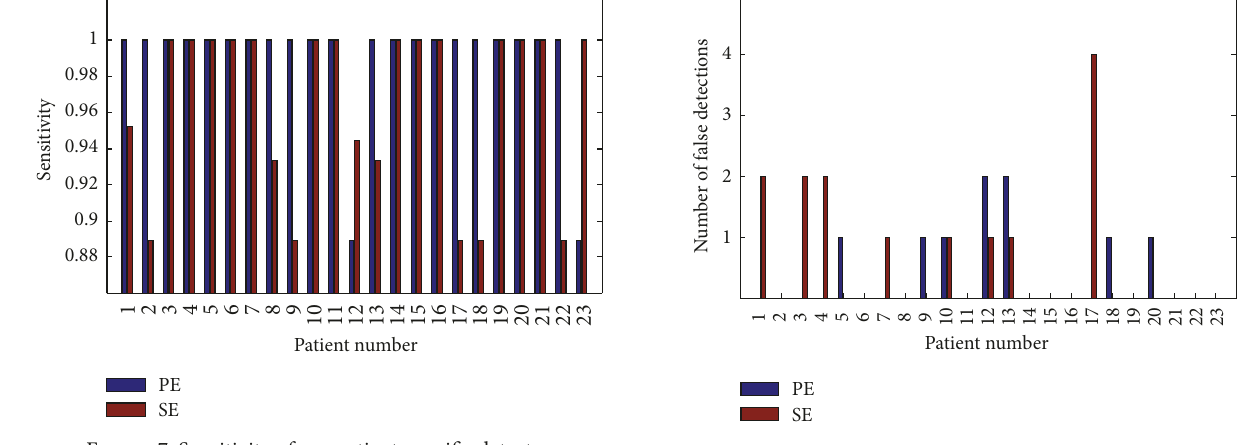
Figure 7: Sensitivity of our patient-specific detector. Figure 8: Specificity of our patient-specific